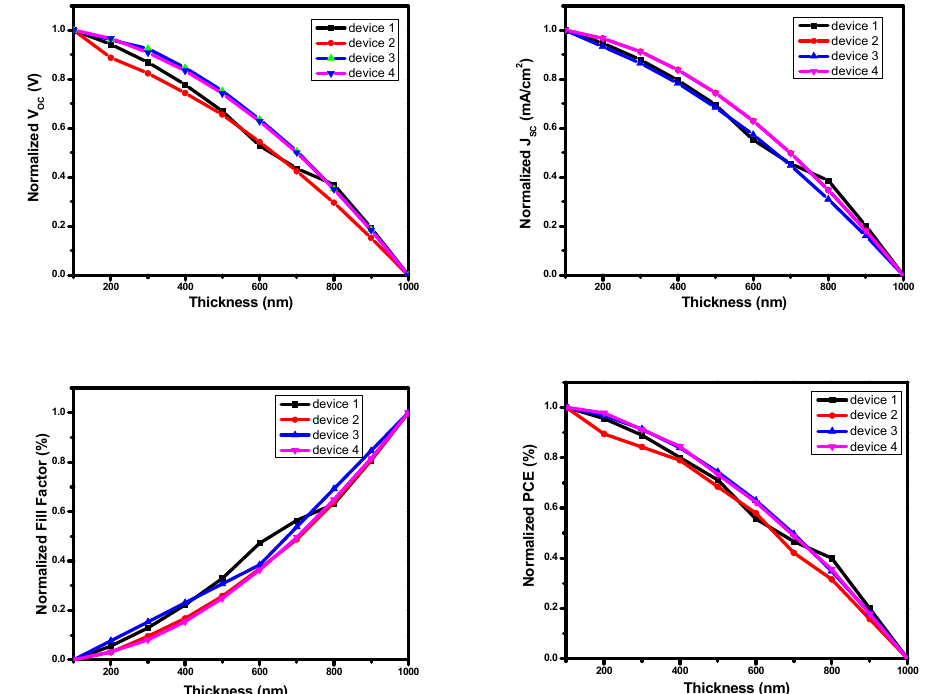
Figure 9. V oc , J sc , fill factor and PCE of devices 1, 2, 3 and 4 for different absorber layer thickness. Table 3. Comparative analysis of cell parameters for K 2 TiI 6 based PSCs. Device